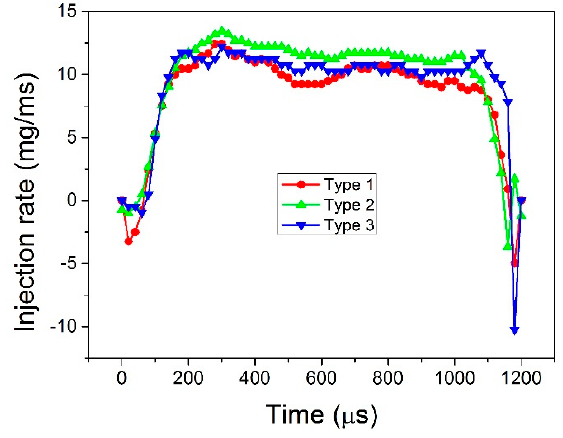
Figure 17. Comparison of the injection rate with various DPIs. Table 9. Comparison of the injection quantity with various DPIs.